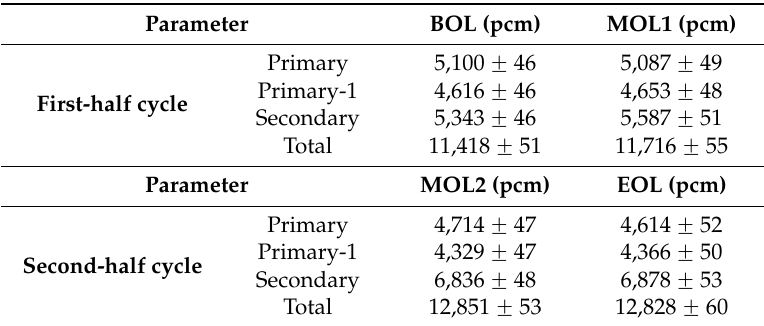
Table 5. Worth the reactivity control system of the MMR